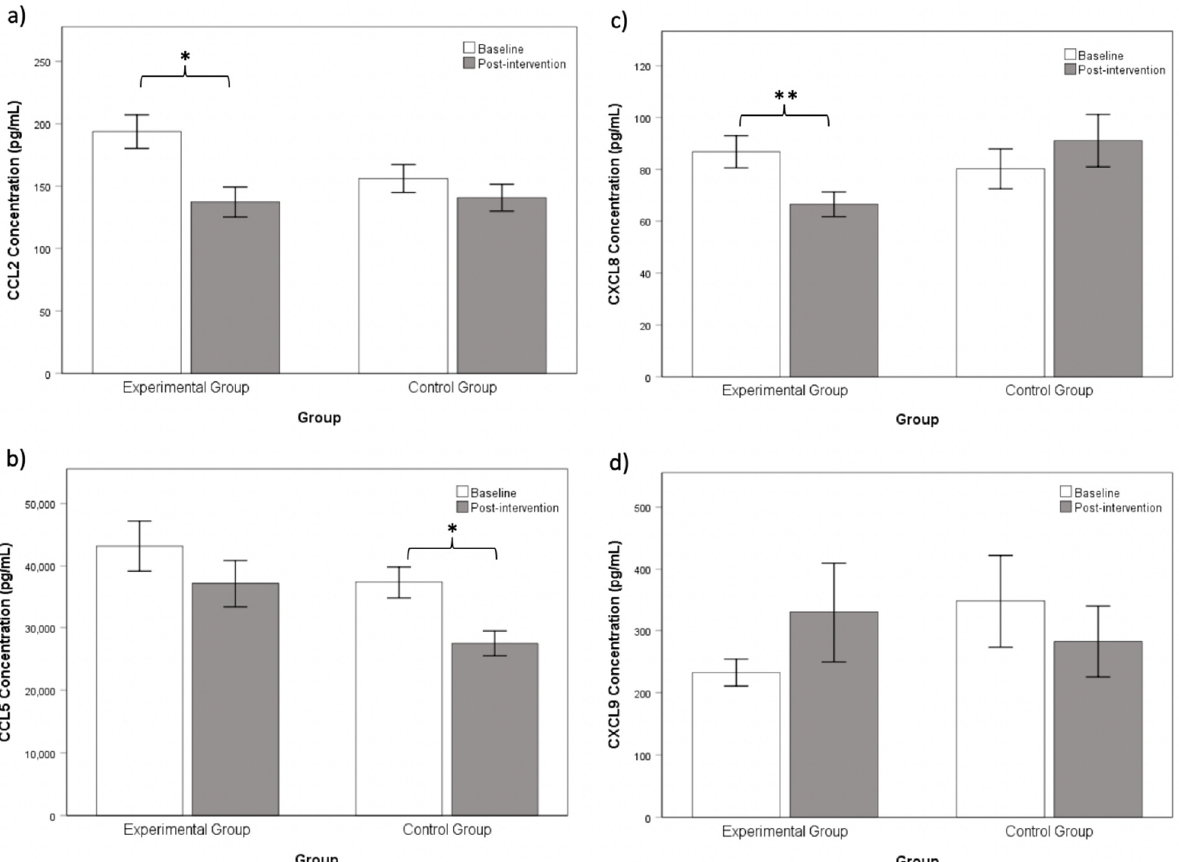
Figure 2. Mean concentrations of four chemokines in the experimental and control group before and after intervention. The experimental group shows a significant reduction in ( a ) CCL2 and ( c ) CXCL8 and a trend of reducing ( b ) CCL5 and ( d ) CXCL9, whereas the control group shows a significant reduction in ( c ) CCL5. * p < 0.013, ** p ≤ 0.001 in paired samples t -test. Error bars represent 1 standard error ± mean.